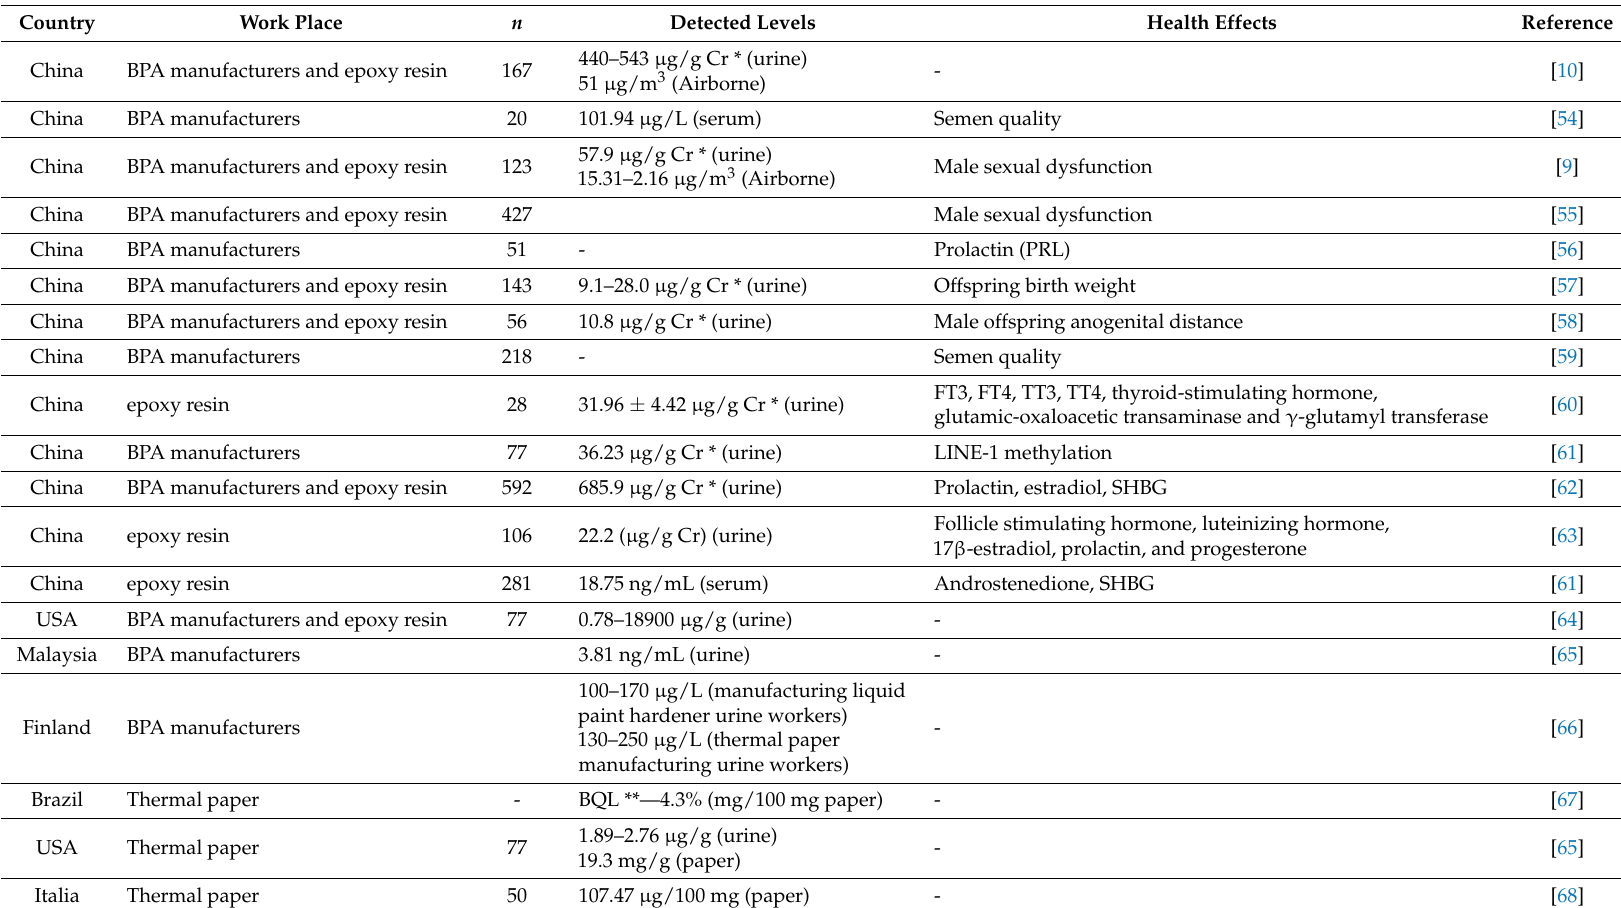
Table 1. Summary of Bisphenol A (BPA) occupational exposure